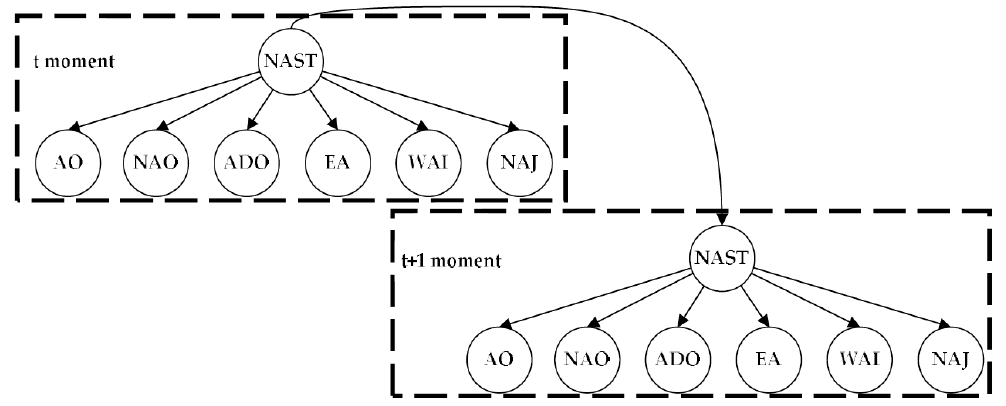
Figure 10. DBN structure between two adjacent time slices of NAST prediction.